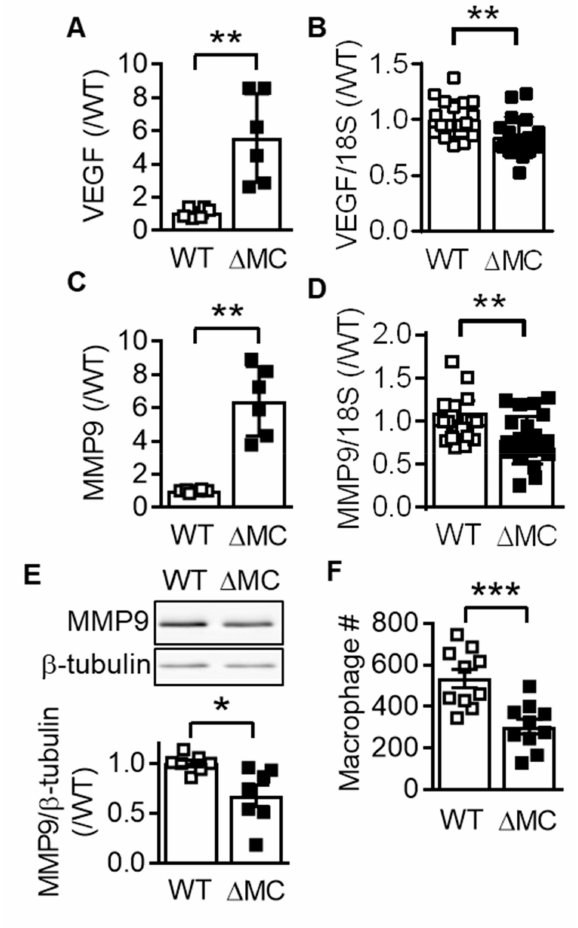
Figure 3. Consequence of myeloid AMPK α 2 deletion on the expression of vascular endothelial cell growth factor (VEGF) and MMP9. ( A ) Vegfa DNA in methylcytosine immunoprecipitates from genomic DNA isolated from wild-type (WT) and AMPK α 2 ∆ MC ( ∆ MC) macrophages ( n = 6). ( B ) VEGF mRNA expression in bone marrow-derived macrophages from wild-type (WT) and AMPK α 2 ∆ MC ( ∆ MC) mice ( n = 10 each in duplicate). ( C ) Mmp9 DNA in methylcytosine immunoprecipitates from genomic DNA isolated from wild-type (WT) and AMPK α 2 ∆ MC ( ∆ MC) macrophages ( n = 6). ( D ) MMP9 mRNA expression in bone marrow-derived macrophages from wild-type (WT) and AMPK α 2 ∆ MC ( ∆ MC) mice ( n = 10 each in duplicate). ( E ) MMP9 protein levels in monocytes from wild-type (WT) and AMPK α 2 ∆ MC ( ∆ MC) mice ( n = 13, each in duplicate). ( F ) Number of wild-type (WT) and AMPK α 2 ∆ MC ( ∆ MC) macrophages that migrated through fibronectin; n = 6, each performed in duplicate (Student’s t -test). * p < 0.05, ** p < 0.01, *** p <